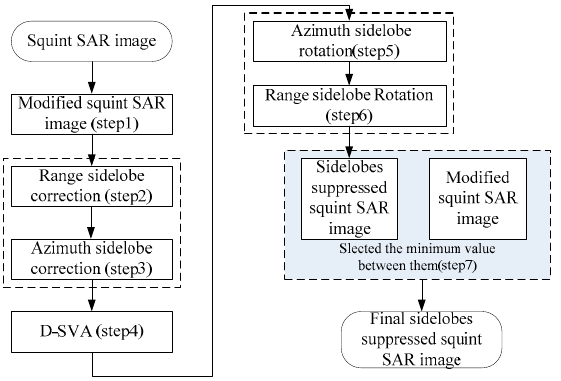
Figure 7. The flowchart of sidelobe reduction algorithm for squint SAR images.